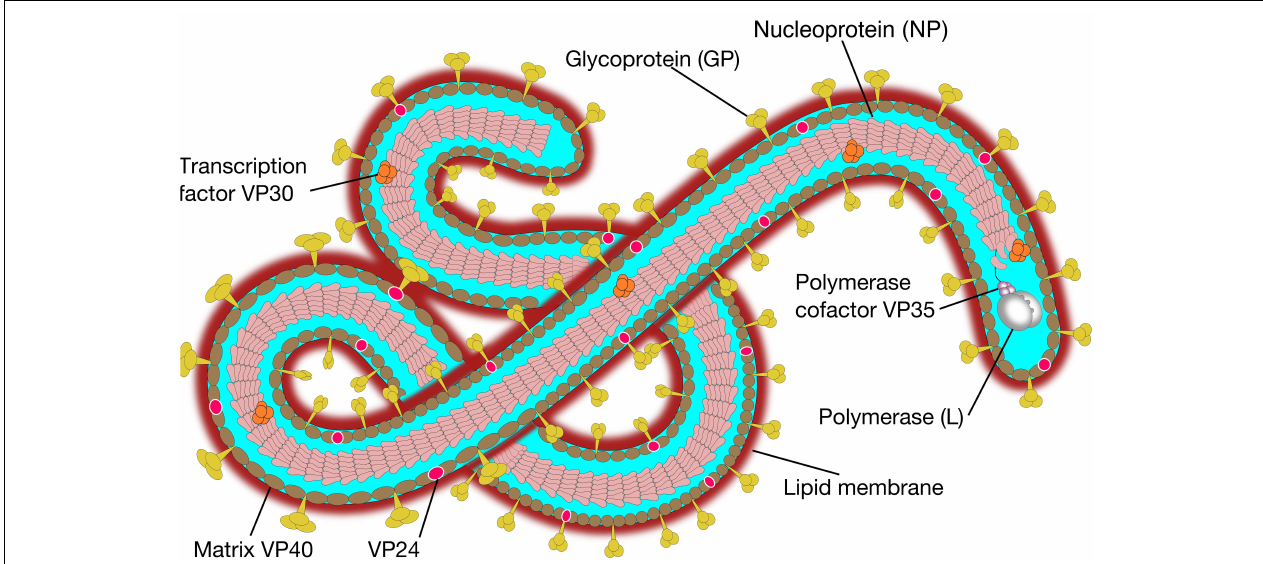
FIGURE 1 | Ebola virus molecular structure. The Ebola genome is composed of 3 leader, nucleoprotein (NP), virion protein 35 (VP35), VP40, glycoprotein (GP), VP30, VP24, polymerase (L) protein and 5 trailer (adapted from SIB SWISS Institute of Bioinformatics,